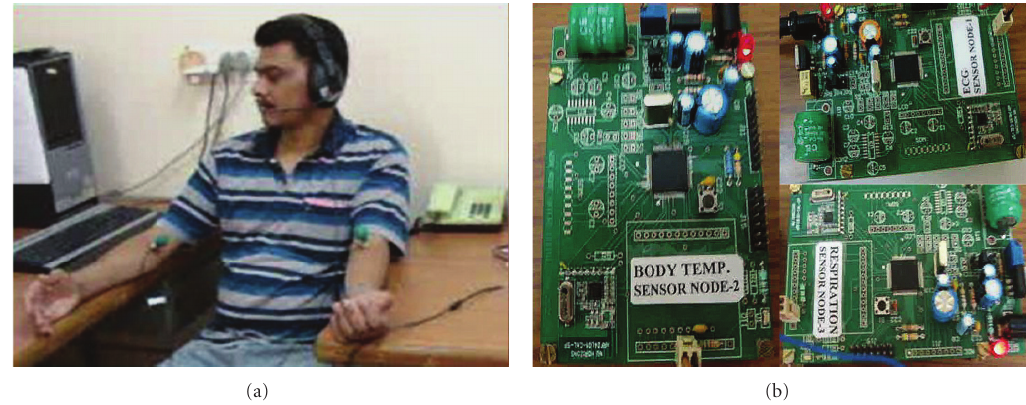
Figure 5: A patient’s vital signs being recorded with three sensors measuring ECG, respiration and